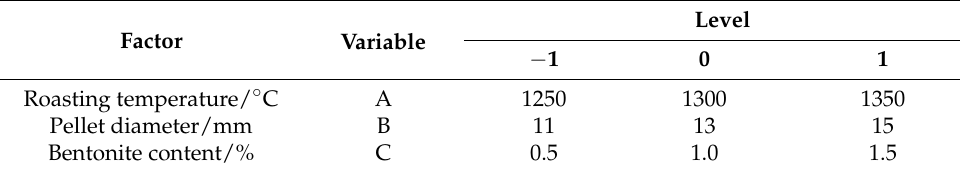
Table 4. Experimental factors and coding.